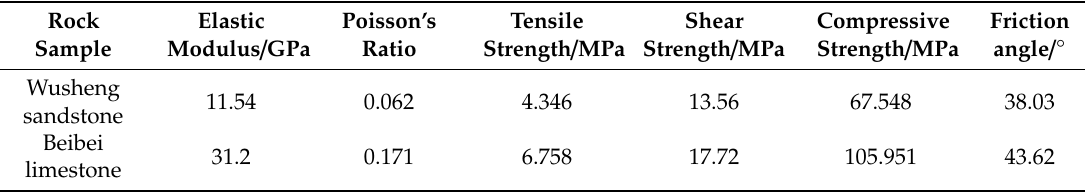
Figure 4. Finite element model of the cutter-rock system: ( a ) Axonometric view; ( b ) Right view. Table 1. Mechanical parameters of rock material [16,19] .